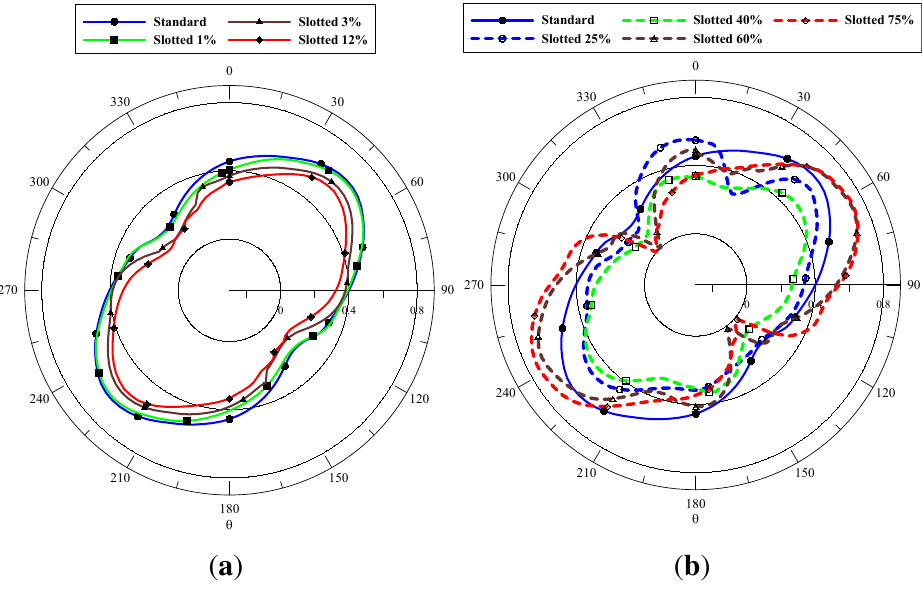
Figure 13. Polar torque coefficient distribution at λ = 0 . 4 .